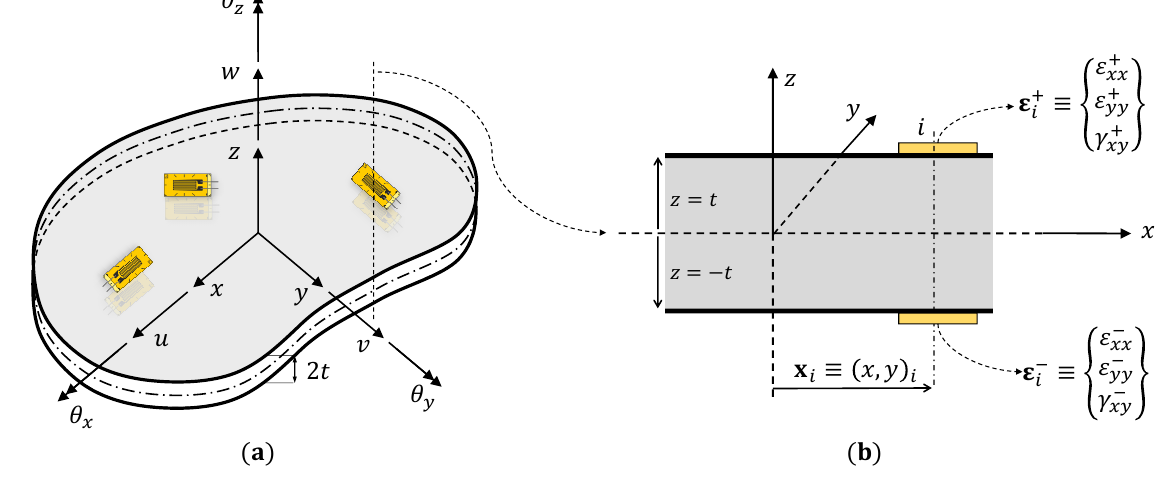
Figure 1. Illustration of the plate structure: ( a ) kinematic variables used to represent the deformations, and ( b ) strain sensors instrumented on the top and bottom surfaces of the